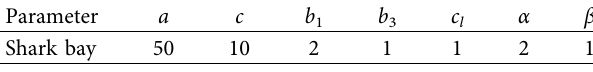
Table 2: Value of parameters.